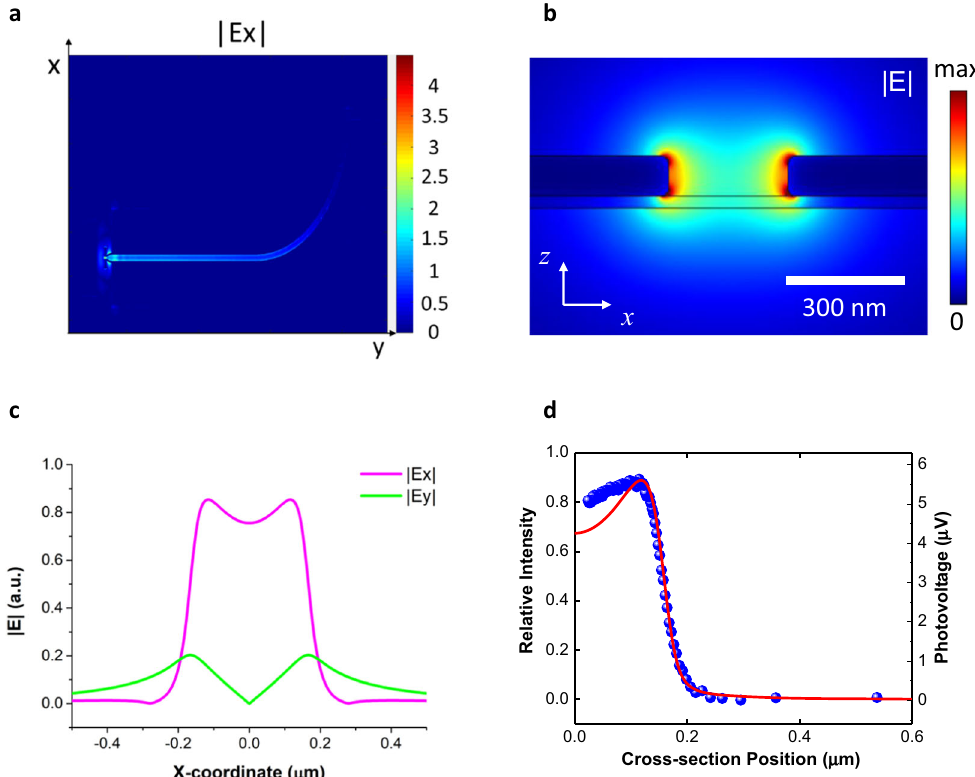
Fig. 4 Comparison of light fi eld pro fi les with theory. a Simulated electric fi eld distribution excited by a laser beam (wavelength of 1550 nm) that falls onto the input antenna (taken in the plane of the waveguide at the half-height of the waveguide and calculated with the help of Lumerical FDTD solutions). b Simulated electric fi eld distribution in the cross-section of the plasmonic slot waveguide calculated with the help of Comsol software. c The line-scan of the norm of electric fi eld calculated at the graphene position. d Comparison of the simulated fi eld pro fi le in the plasmonic slot waveguide (the red solid line) with the reconstructed pro fi le obtained with a p-n junction moved in graphene by gating (the blue